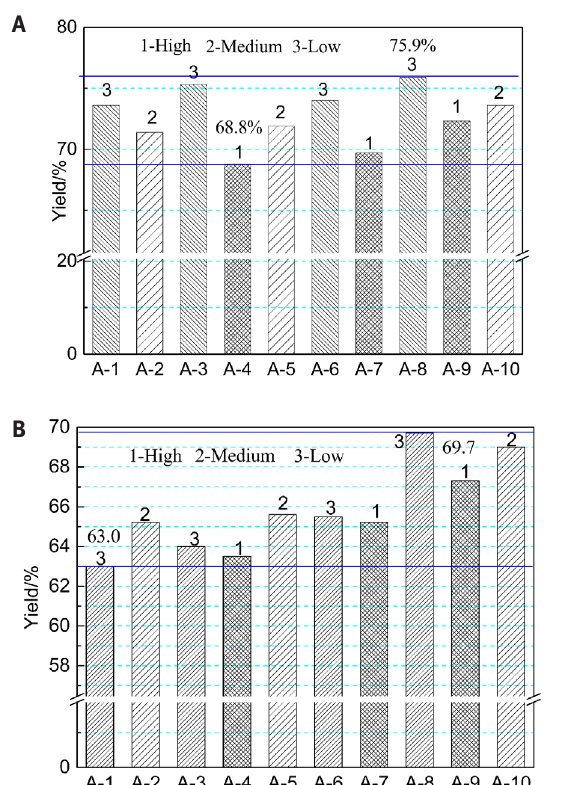
Figure 2: Yield of pyrolysis without activation (a) and pyrolysis with